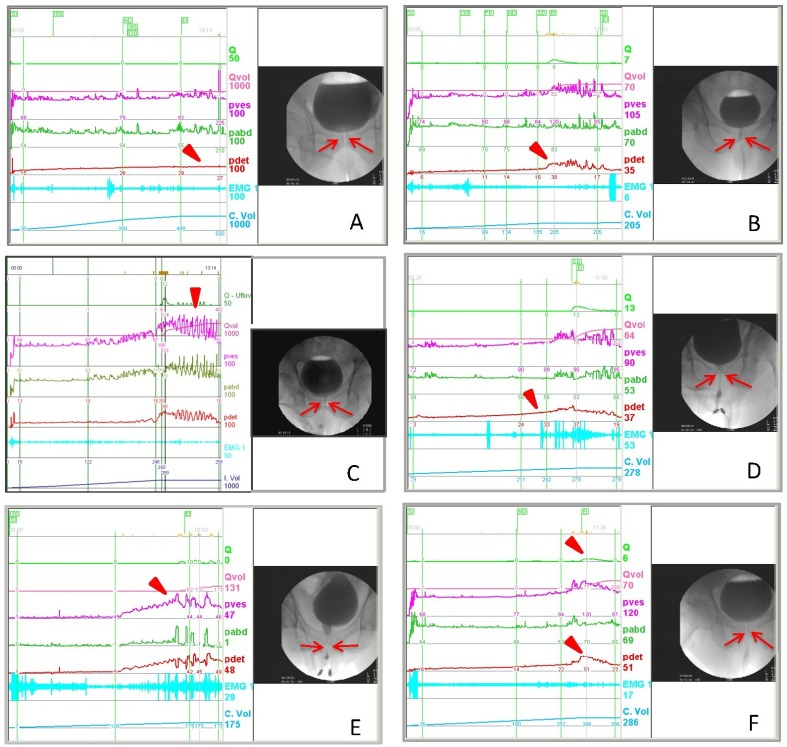
The videourodynamic characteristics of patients with underactive bladder.(A) Detrusor acontractile, reduced bladder sensation, no detrusor contractility (arrow head), and a tight bladder neck (arrows). (B) Low detrusor contractility, low detrusor pressure (arrow heads) and low Qmax, open bladder outlet during voiding (arrows). (C) Low detrusor contractility and early termination, patient used abdominal pressure to empty the bladder (arrow head), the bladder outlet is open (arrows). (D) Detrusor overactivity and impaired contractility, patient had a hypertonic bladder at capacity (arrow head) but the voiding pressure and Qmax are low, the bladder outlet is open (arrows). (E) Slowly increased detrusor pressure (arrow head) and poor relaxing urethral sphincter (arrows). (F) Normal voiding pressure and low Qmax (arrow head), with a narrow bladder neck during voiding (arrows).